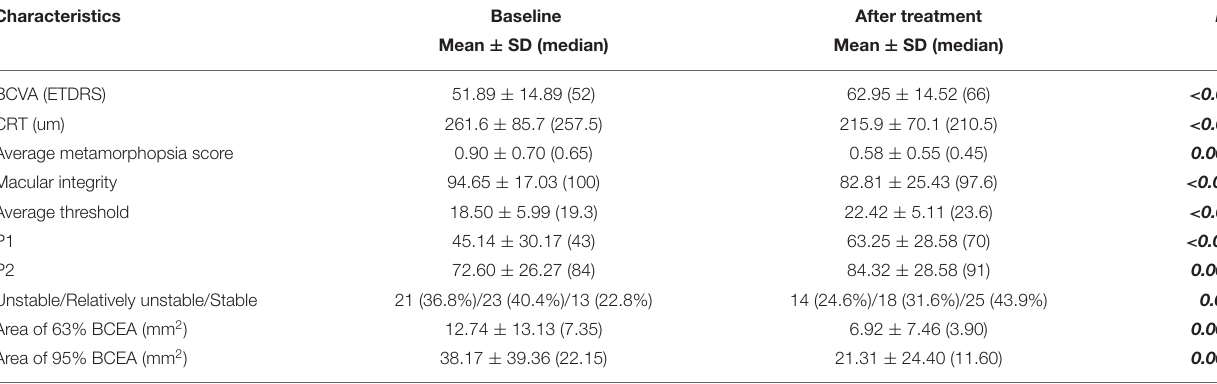
TABLE 2 | Functional visual performance before and after anti-VEGF